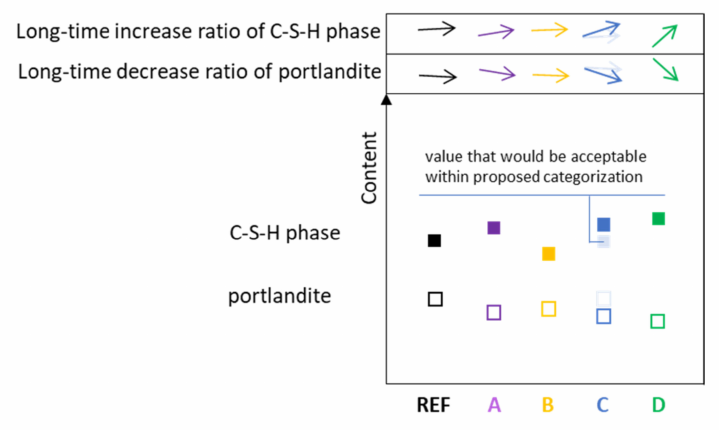
Figure 23. Prediction of the content of hydration phases and their development over time in CC depending on the type of mineral